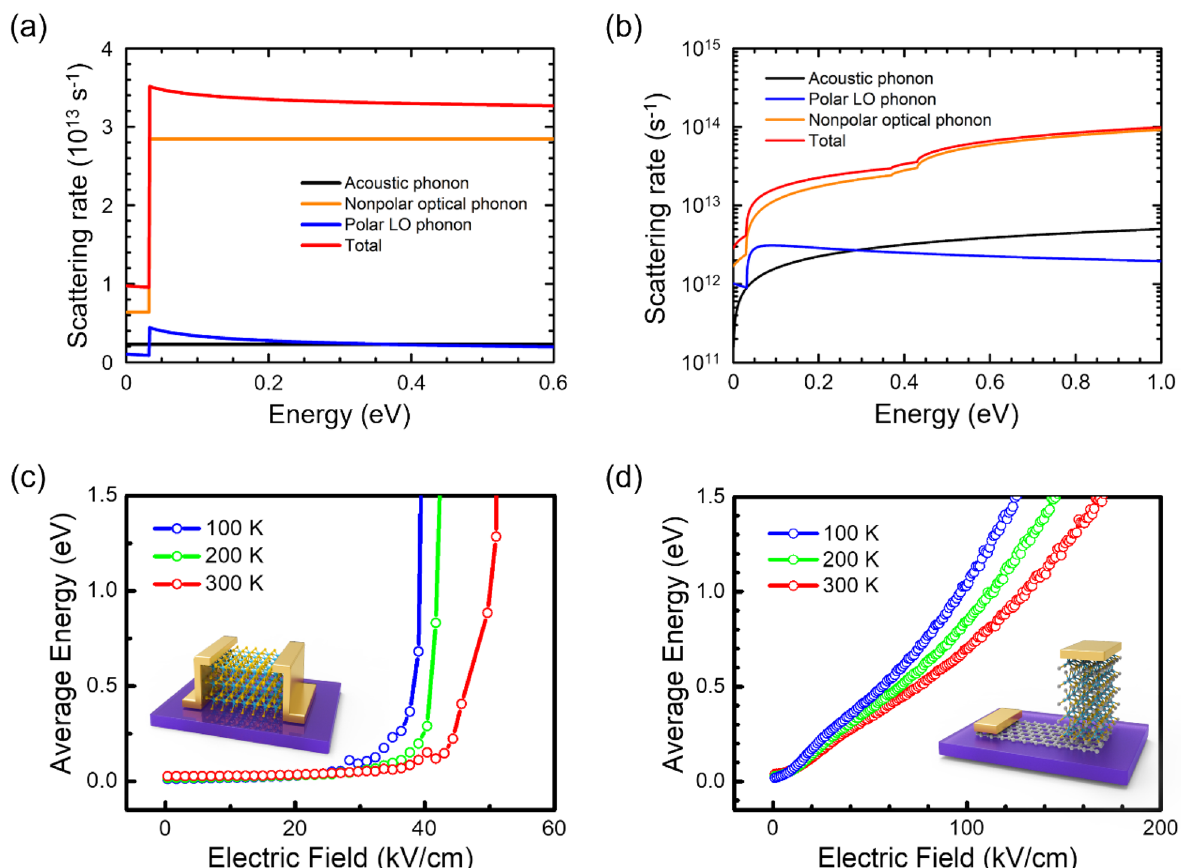
Fig. 3 Theoretical analysis of impact ionization. a Two-dimensional scattering rates for different phonon scatterings as a function of the carrier energy at T 300 K. The acoustic phonon deformation potential is 2 eV and the nonpolar optical phonon deformation potential is 4 = b Three-dimensional scattering rates for different phonon scatterings as a function of the carrier energy at T acoustic phonon deformation potential is 3 eV and the nonpolar optical phonon deformation potential is 5 average carrier energy for in-plane transport as a function of the electric field at T energy for out-of-plane transport as a function of the electric field at T the carrier energy for impact ionization, is exceptionally large for out-of-plane transport compared with